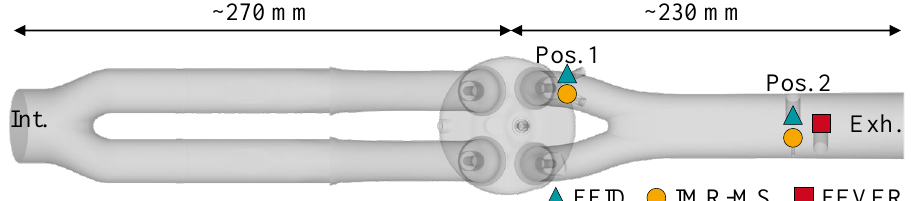
Figure 1. Top view of the CFD geometry with an overview of the emission sampling positions (Pos.) and length of the intake (Int.) and exhaust (Exh.) regions. FFID, fast flame ionization detector; IMR-MS, ion molecule reaction mass spectrometer; FEVER, FEV emission rate.